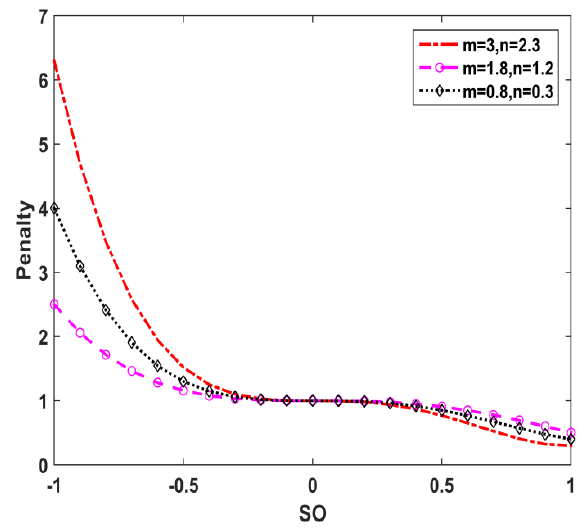
Figure 4. SOC correction function under different coefficients.